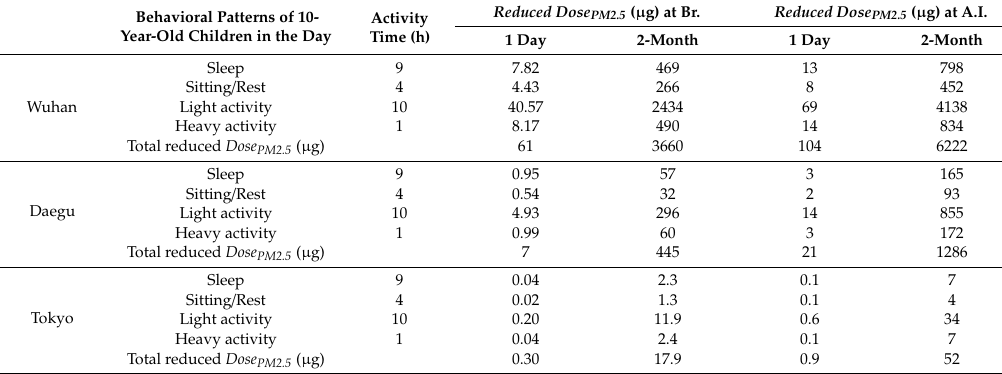
Table 2. Reduced Dose PM 2.5 ( µ g) at the bronchiolar and AI regions of the 10-year-old children per day and over two months after the city lockdown / self-reflection of each